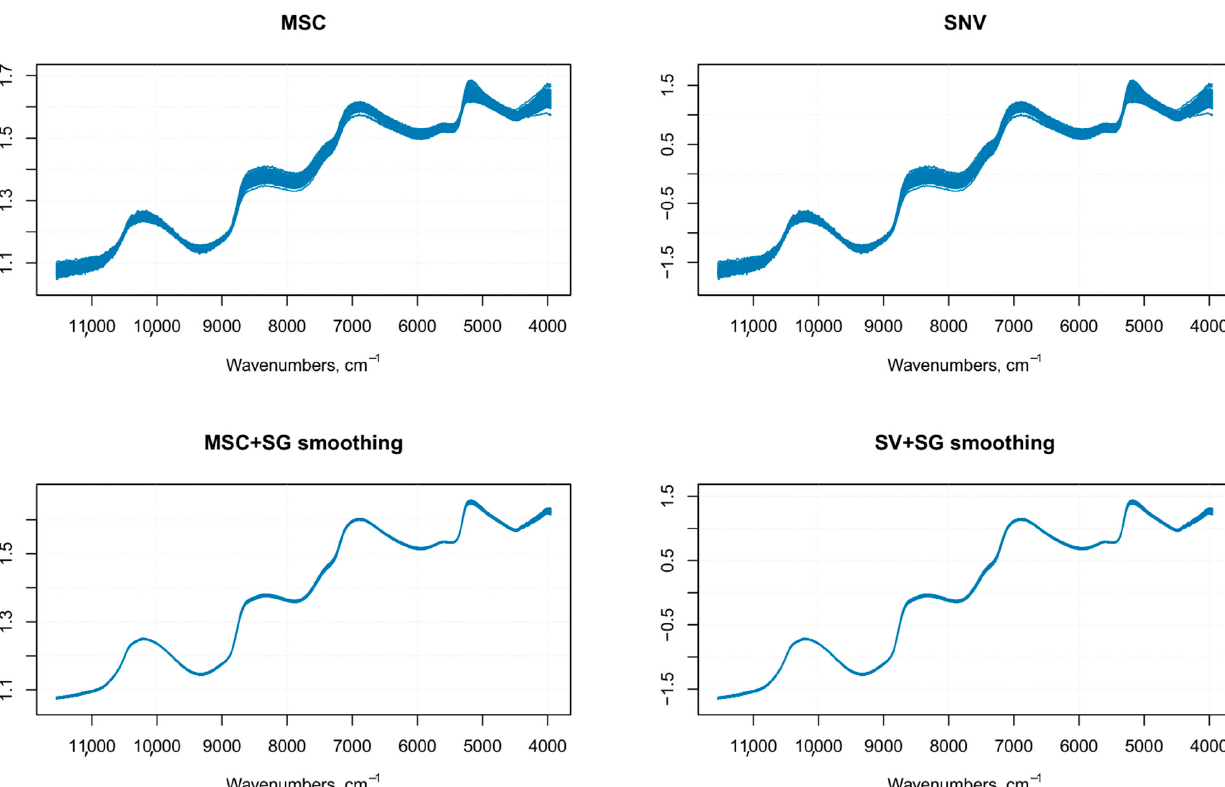
Figure 3. Results of spectral data pretreatment using multiplicative scatter correction (MSC) and standard normal variate (SNV) with (bottom spectra) or without (top spectra) smoothing.